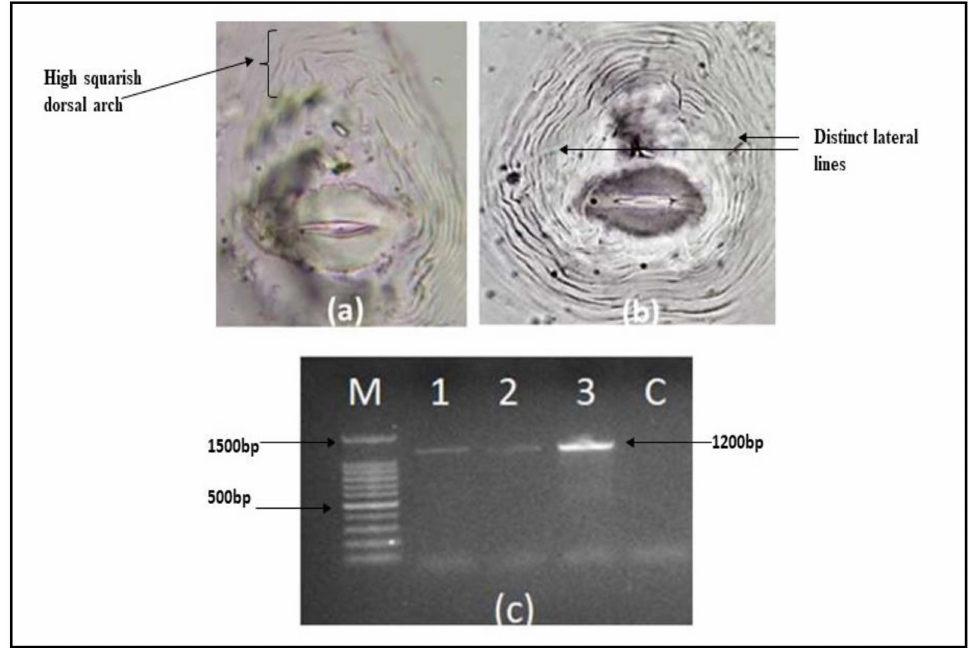
Figure 1. Perineal pattern of adult root-knot nematode females: ( a ) Meloidogyne incognita (showing high squarish dorsal arch with no lateral lines); ( b ) Meloidogyne javanica (perineal pattern with distinct lateral lines); ( c ) agarose gel (1%), showing amplification of 1200 bp that corresponds to Meloidogyne incognita sp. of root-knot nematode, using the SCAR Finc/Rinc primer from all of the three polyhouses; 1 = location-I; 2 = location-II; 3 = location-III; C—negative control; M—DNA marker (100